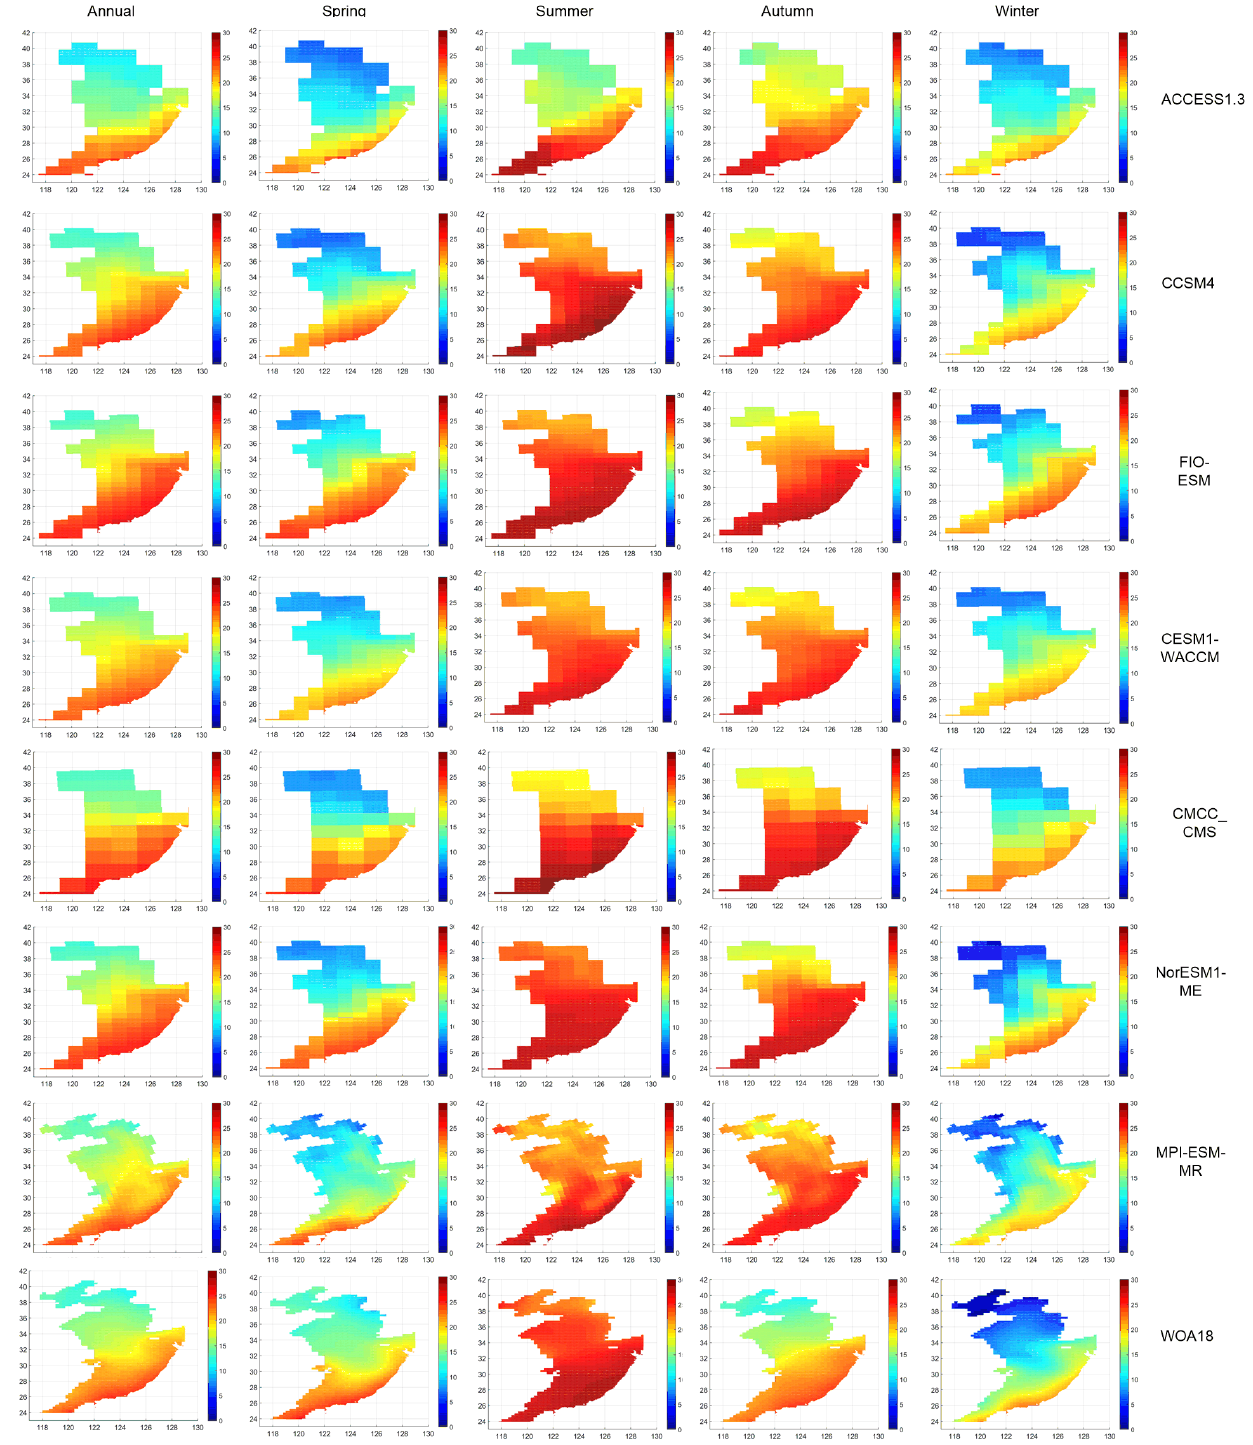
Figure 2. Model validation: the comparison of CMIP5 simulation results with WOA18. The first row to seventh row illustrate the result of seven CMIP5 models: ACCESS1.3, CCSM4, FIO-ESM, CESM1-CAM5, CMCC-CMS, NorESM1-ME, and MPI-ESM-MR, respectively. The last row shows the observation result from WOA18 data. The first to fifth column present the results in the year round, spring, summer, autumn, and winter of 2010,